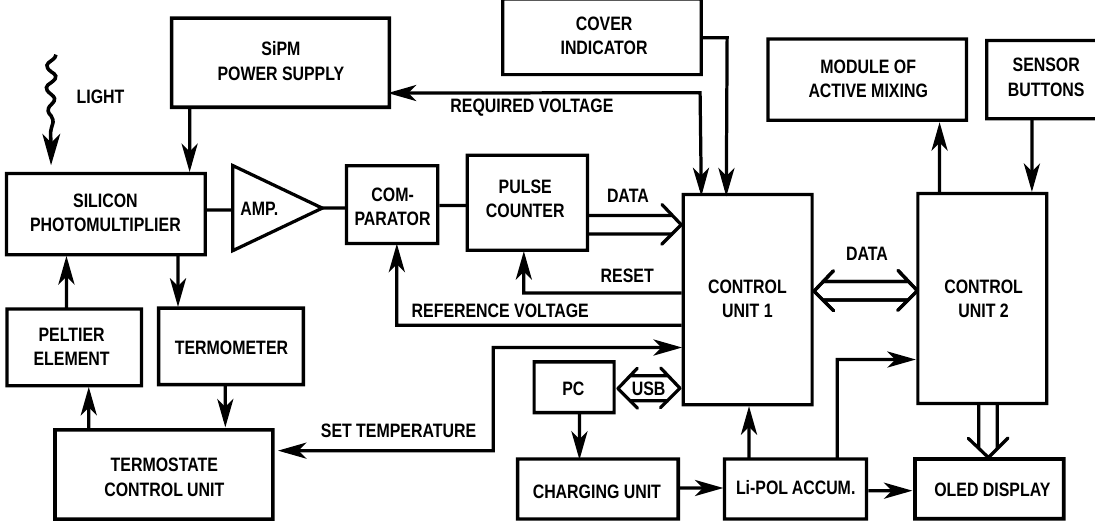
Figure 2. The principal block diagram of electrical circuits used in proposed